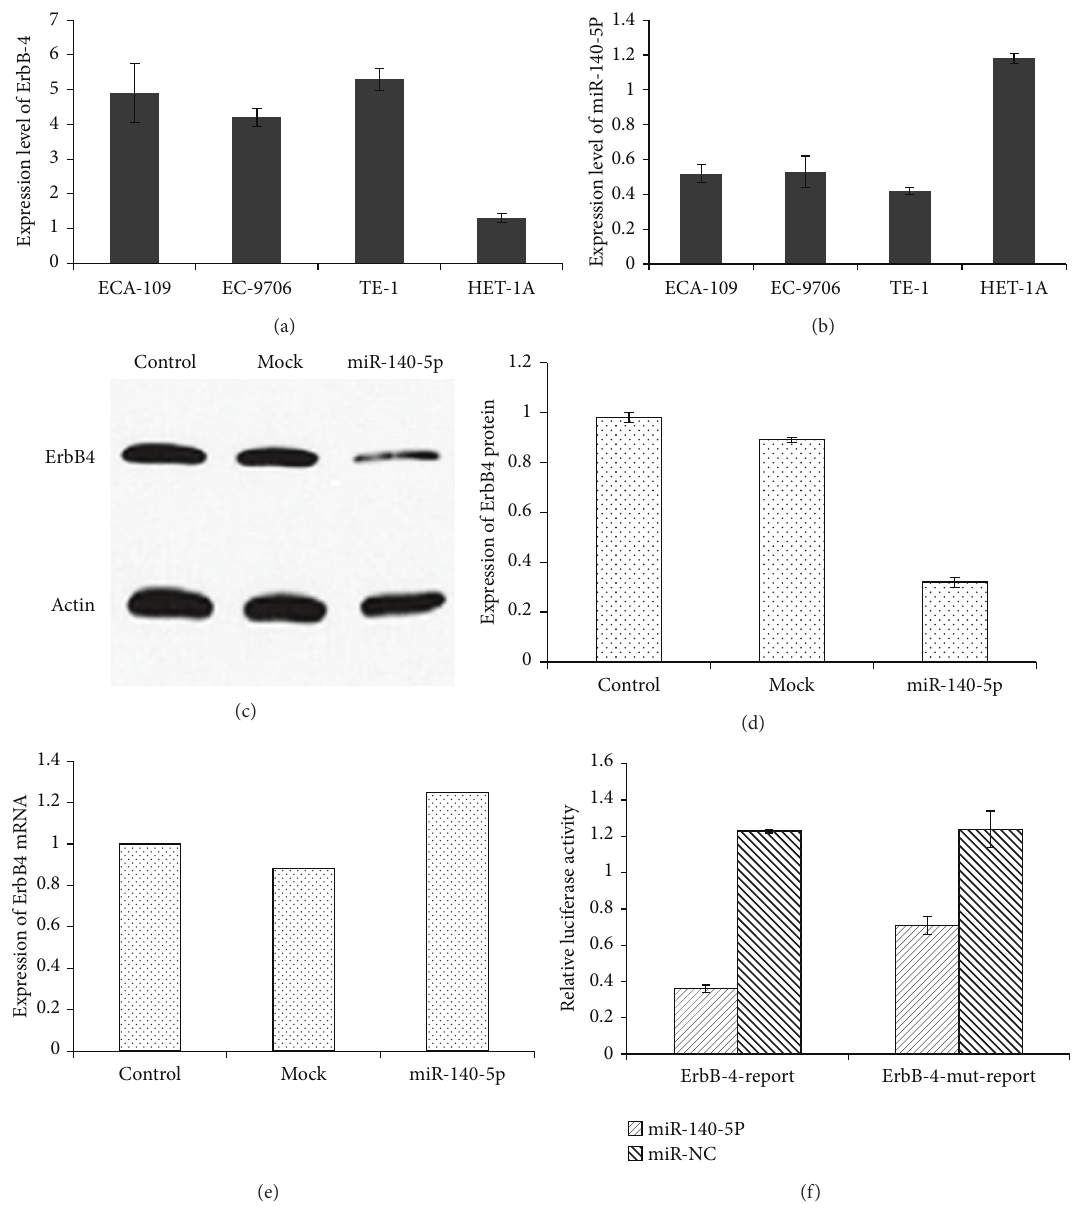
Figure 2: miR-140-5p controls the ErbB4 expression. ErbB4 expression in esophageal cancer cell lines (ECA 109, EC9706, and TE-1) and normal cell line (HET-1A) via western blot analysis (a). miR-140-5p expression in these cell lines (b). Western blot analysis of effect of miR- 140-5p on ErbB4 protein expression (c and d). RT-PCR analysis of effect of miR-140-5p on ErbB4 mRNA expression (e). Analysis of luciferase reporter activity in EC9706 cancer cell line (f). The luciferase activity was examined by Renilla luciferase